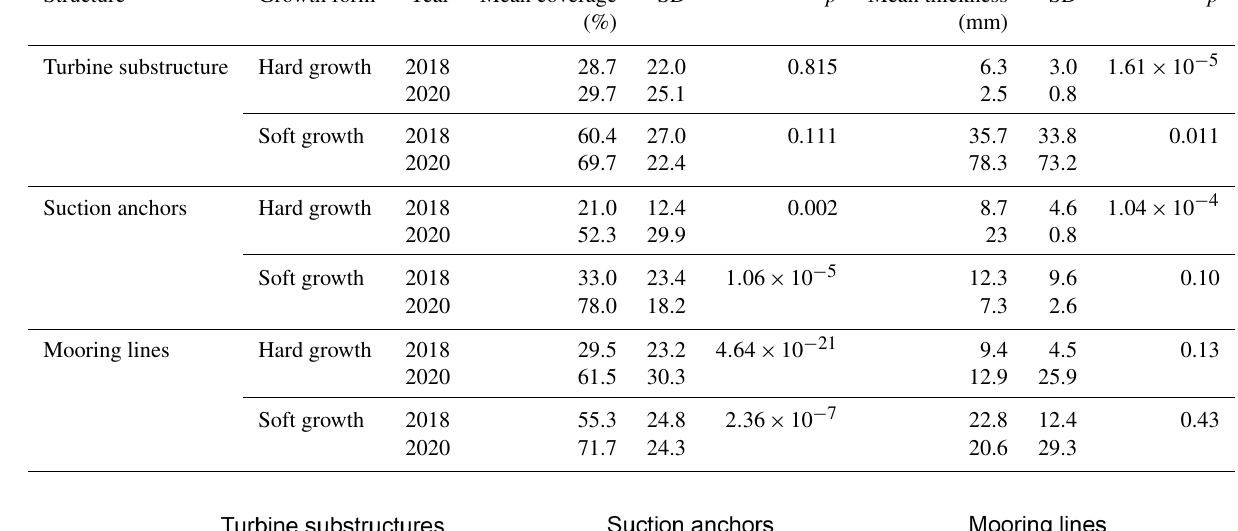
Suction anchors